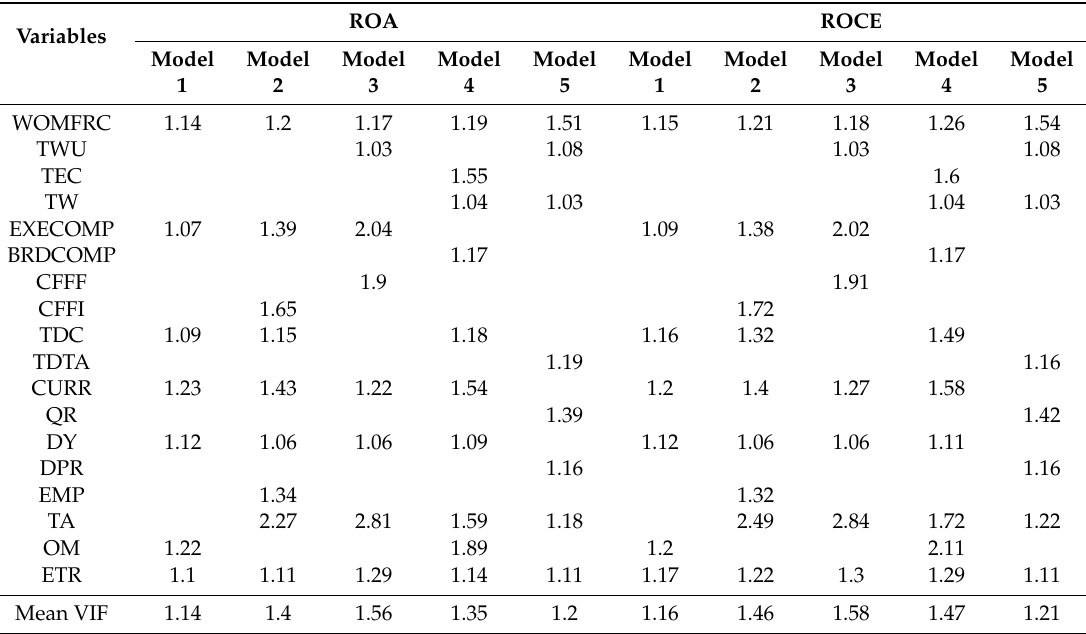
Table 8. Variance inflation factors (VIFs) for the panel data pooled regression models in regard to the influence of water, waste, and energy consumption, alongside firm and corporate governance-specific variables, on return on assets and return on common equity.